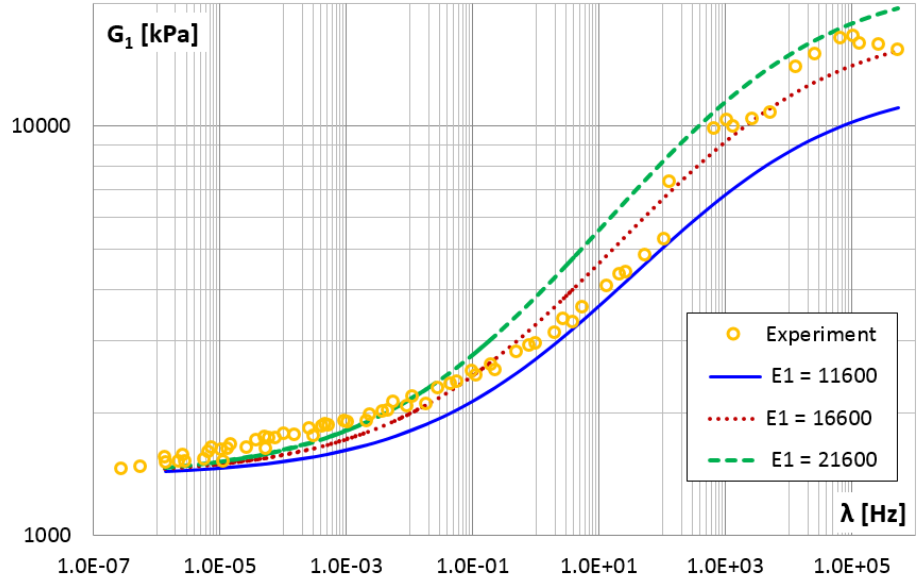
Figure 22. The shear storage modulus G 1 vs. frequency for different values of parameter E 1 .